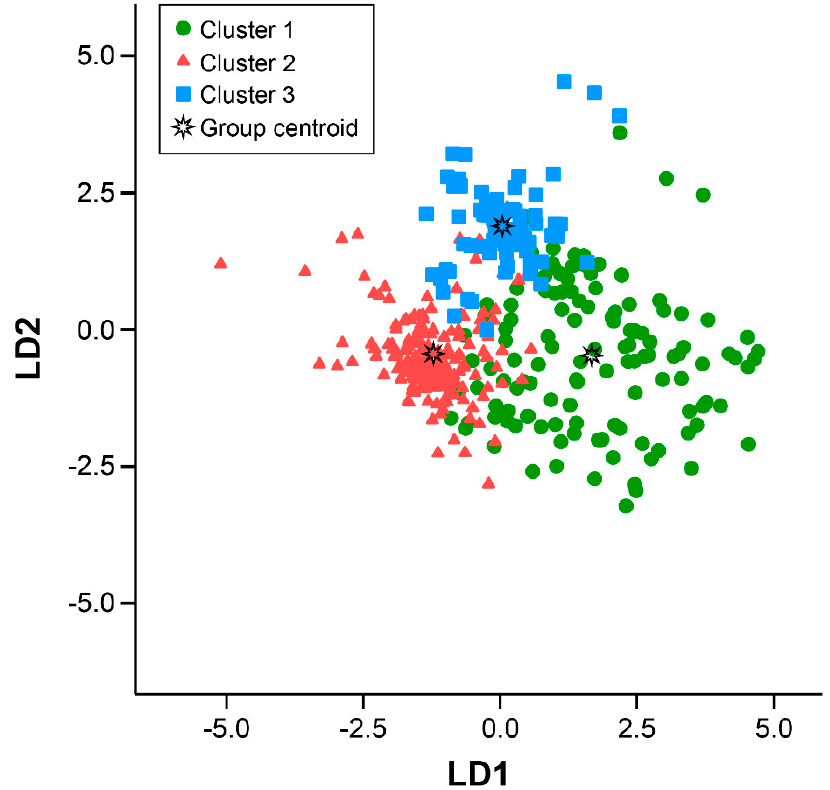
Figure 2. Three subgroups of patients with SLE identified at an accuracy of 84.5%. Canonical discriminant function shows that the LD was 72.5% in Cluster 1, 85.3% in Cluster 2, and 92.9% in Cluster 3. LD, linear discriminant; SLE, systemic lupus